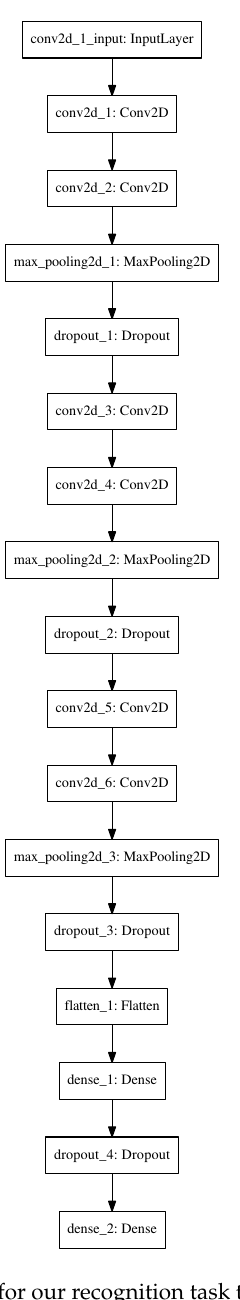
Figure 5. The CNN Model used for our recognition task targeting three sports